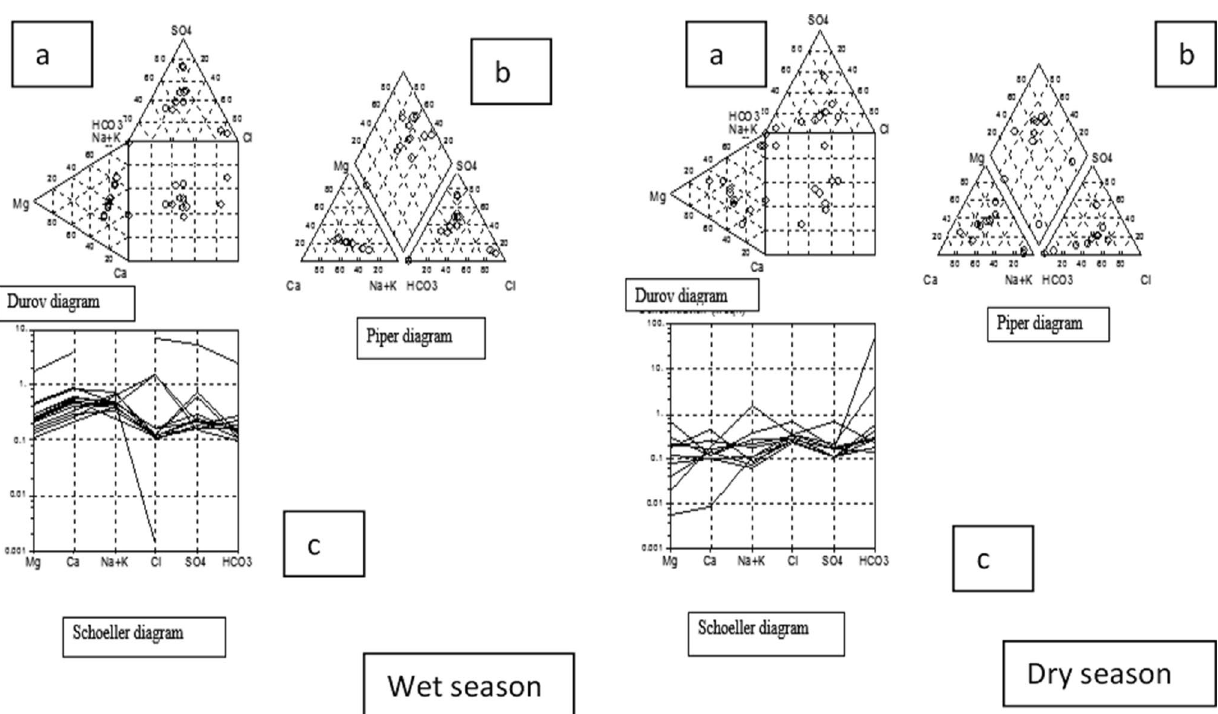
Fig. 3 Diagrammatical representation of hydrochemical species a Durov, b Piper and c Schoeller in Aguleri zone